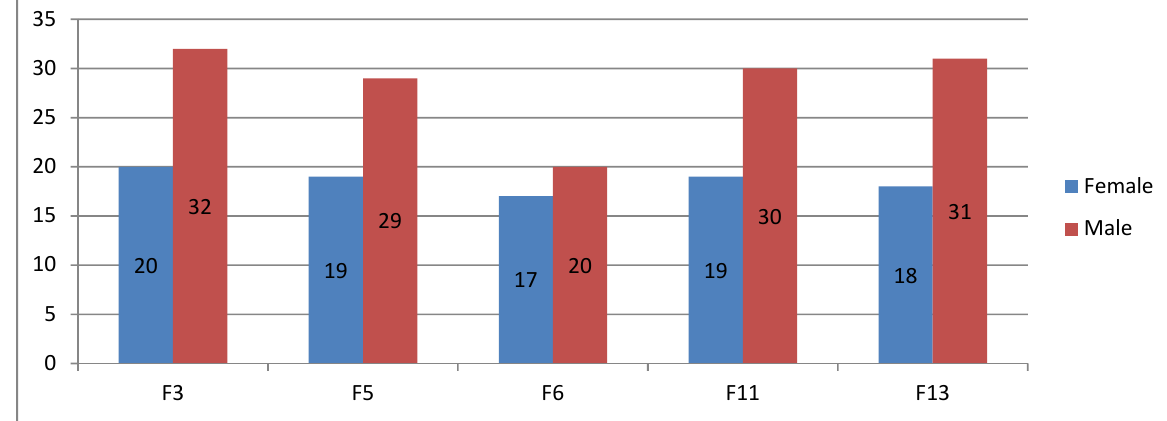
Fig. 2. The frequency of answers to management related questions